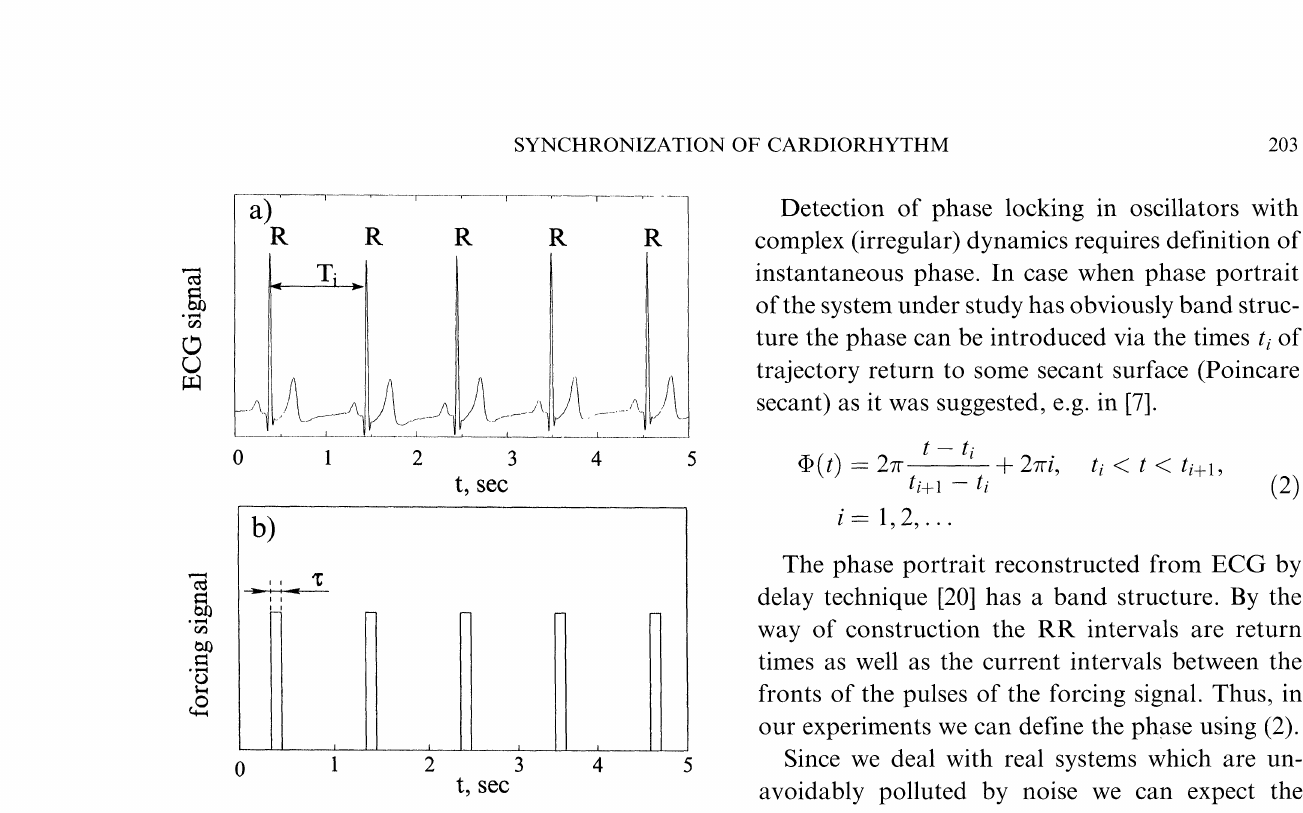
FIGURE (a) Typical human electrocardiogramme; (b) Forcing signal. conditions, or aperiodic with instantaneous periods coinciding with the RR intervals of another